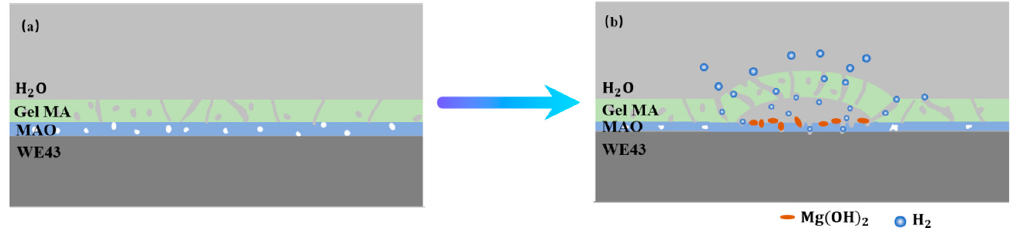
Figure 11. Schematic illustrations of degradation mechanism of the porous GelMA/MAO composite coatings on the WE43 magnesium alloy: ( a ) state of composite coating at the initial stage. ( b ) the blistering and final peeling-off of GelMA hydrogel under the pressure of self-absorption expansion and corrosion products.